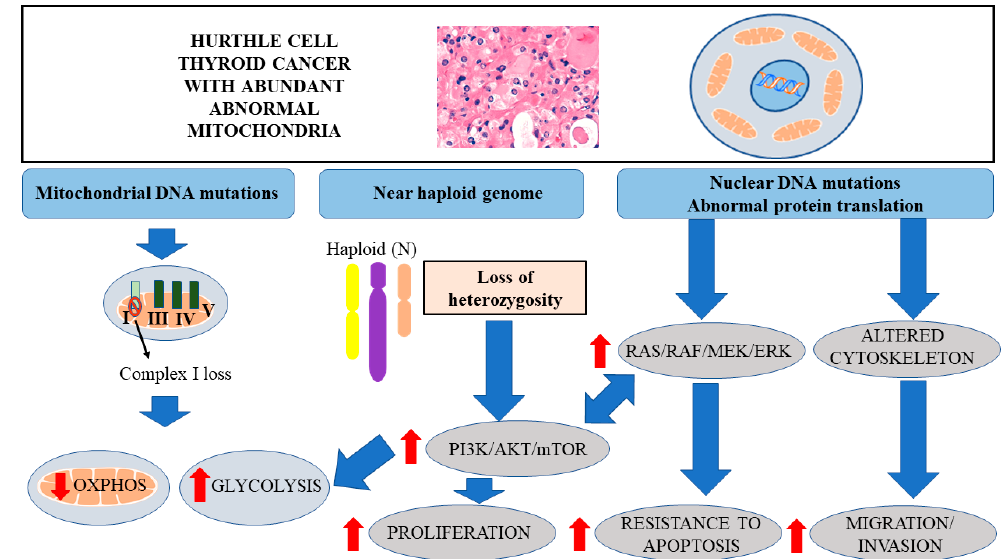
Figure 1. Diagram representing the role of mitochondrial mutations, near haploid genome and somatic mutations in Hürthle cell thyroid cancer development. Mitochondrial mutations, leading to the inactivation of complex I of the respiratory chain, are associated with the decreased OXPHOS and increased glycolysis. Near haploid genome, associated with the inactivation of several tumor suppressors, leads to the overactivation of PI3K/AKT/mTOR signaling pathway, enhancing cell proliferation and glycolysis. Somatic mutations in nuclear DNA are associated with abnormal protein translation, overactivation of PI3K/AKT/mTOR and RAS/RAF/MEK/ERK signaling pathways and altered cytoskeleton, leading to enhanced proliferation, resistance to apoptosis, and metastatic potential.